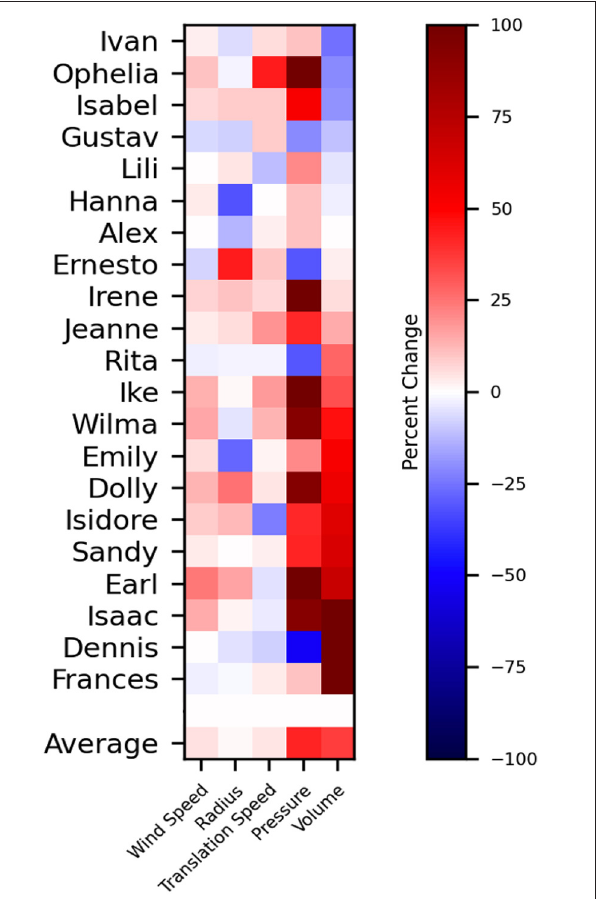
FIGURE 11 | Differences (PGW-CTRL) in average hurricane characteristics arranged from top to bottom by increasing inundation volume. Decreases in translation speed and pressure contribute positively to larger surges so signs are reversed in this figure accordingly (e.g., decreases in translation speed are defined as positive